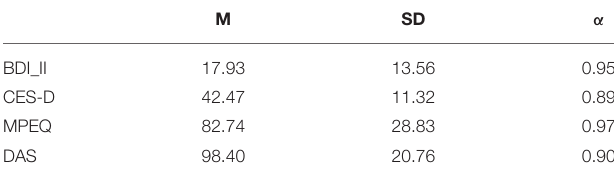
TABLE 1 | Means, standard deviations, and reliability. TABLE 2 | Meta-emotional problem questionnaire